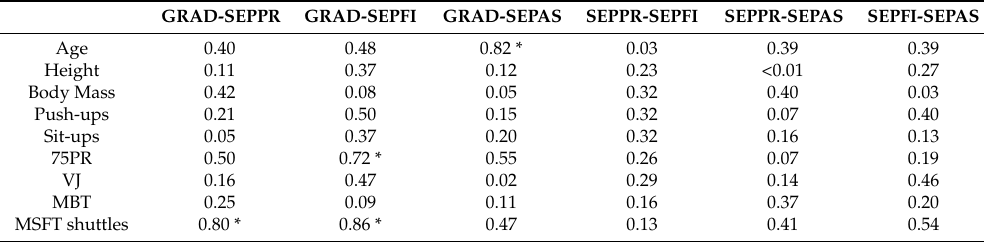
* Moderate effect for the pairwise